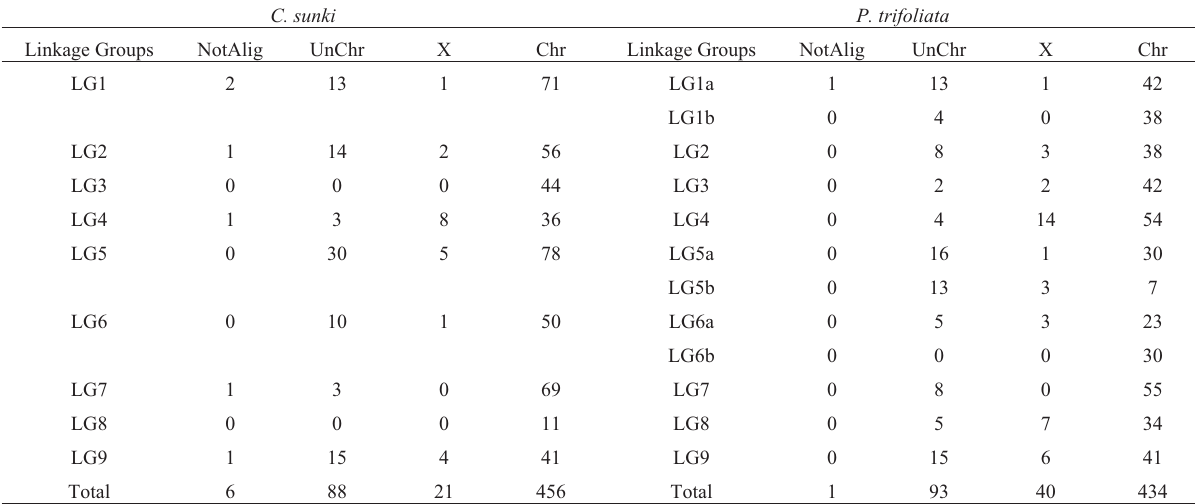
Table 2 - Number of markers not aligned to the reference genome, aligned on the unassigned chromosome (UnChr), in another chromosome (X) or in the corresponding chromosome